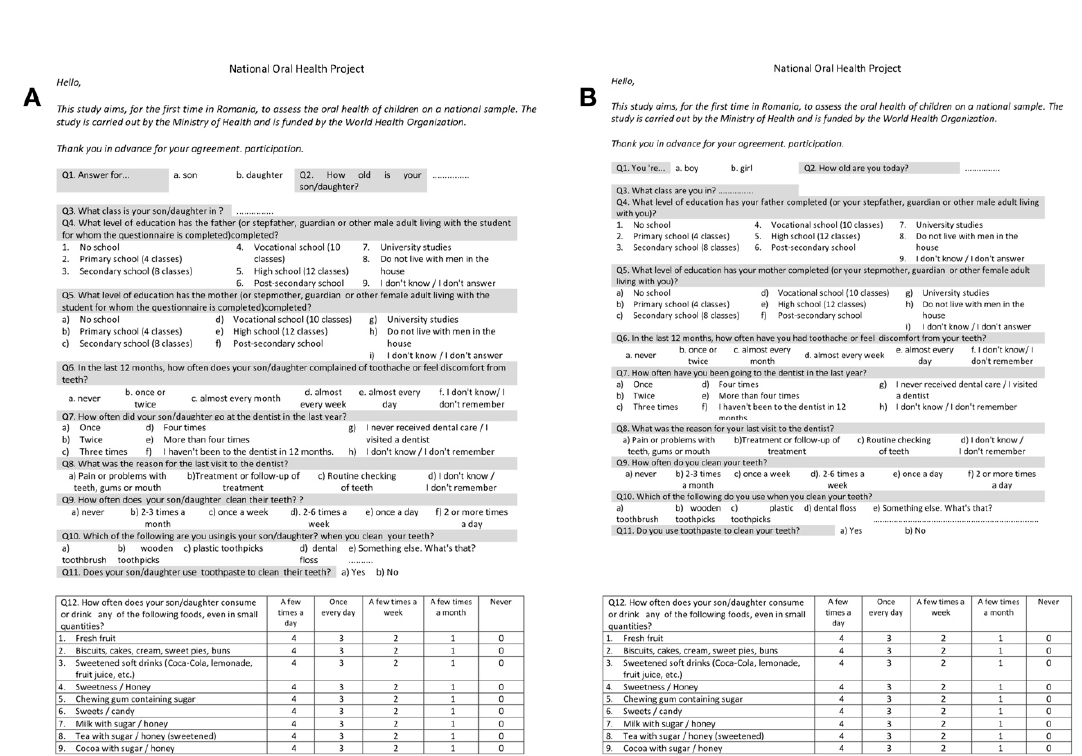
12-year-old Figure 1. (A ) questionnaire given for parents of 6-year-old children; ( B ) questionnaire given for 12-year-old children.